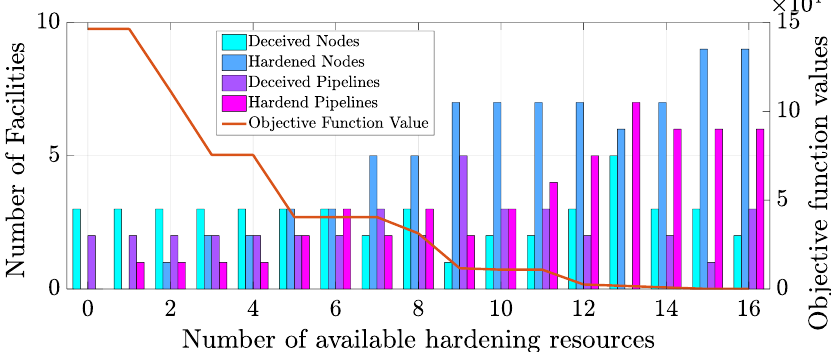
Figure 5. Model results verification: defender–attacker strategies with deception.